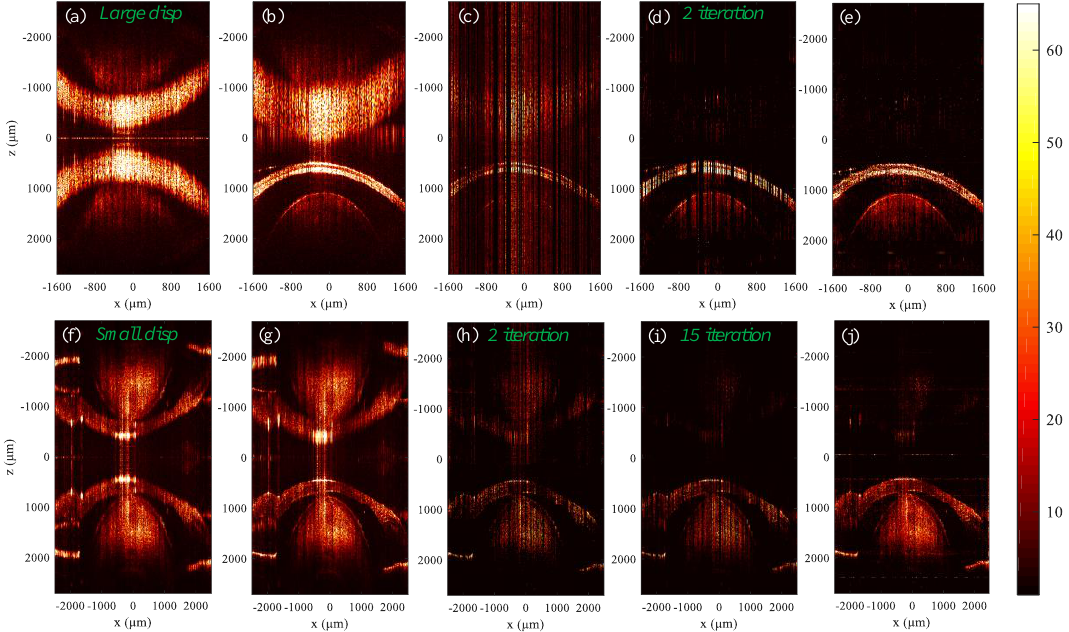
Figure 3. Structural imaging results using a fisheye. ( a )–( e ) show the results of the system with large dispersion mismatch, and ( i )–( j ) show the results for the system with small dispersion. ( a ) and ( f ) Images without dispersion compensation; ( b ) and ( g ) Images with dispersion compensation; ( c ) Image obtained from 2D under-sampled spectral data; ( d ), ( h ), and ( i ) Results after reconstruction of axial data; ( e ) and ( j ) Reconstructed full-depth 2D images.